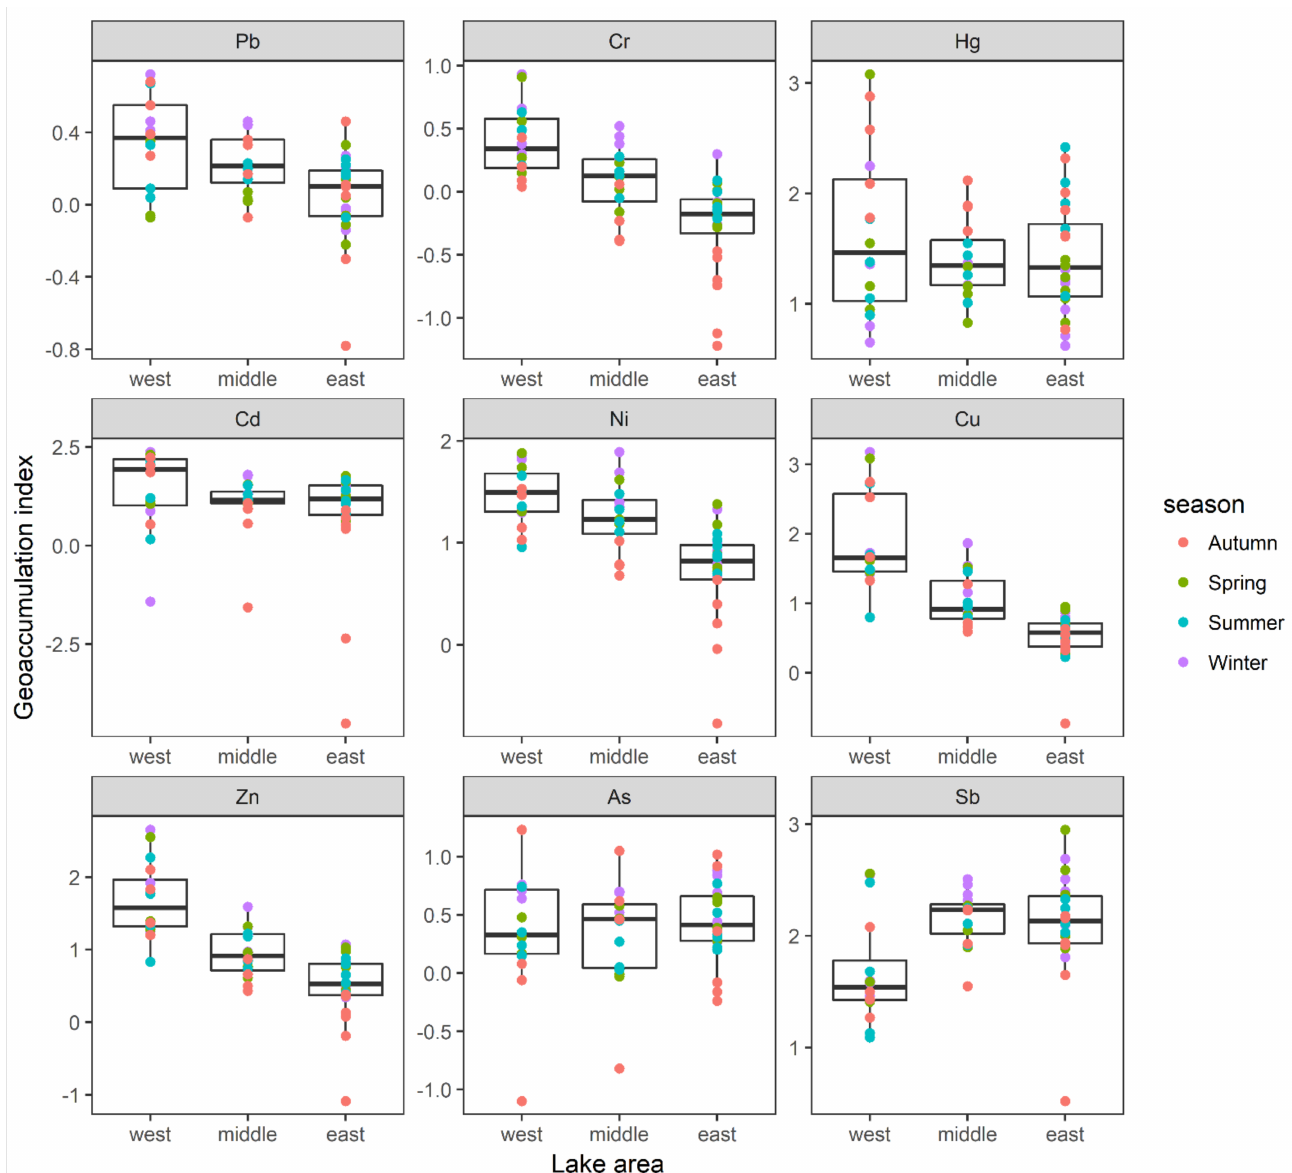
Figure 5. The spatial distributions of I geo of each heavy metal were displayed in three lake areas. Boxes represent the 25th to 75th percentiles; straight lines within the boxes mark the median; and the small dots indicate the average values of four